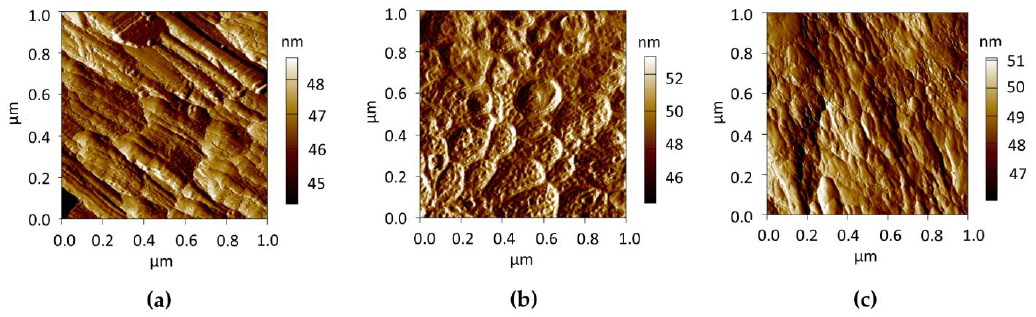
Figure 1. Atomic force microscopy (AFM) images of the samples surfaces: ( a ) GHA10, ( b ) GHA50 and ( c ) GHA100.